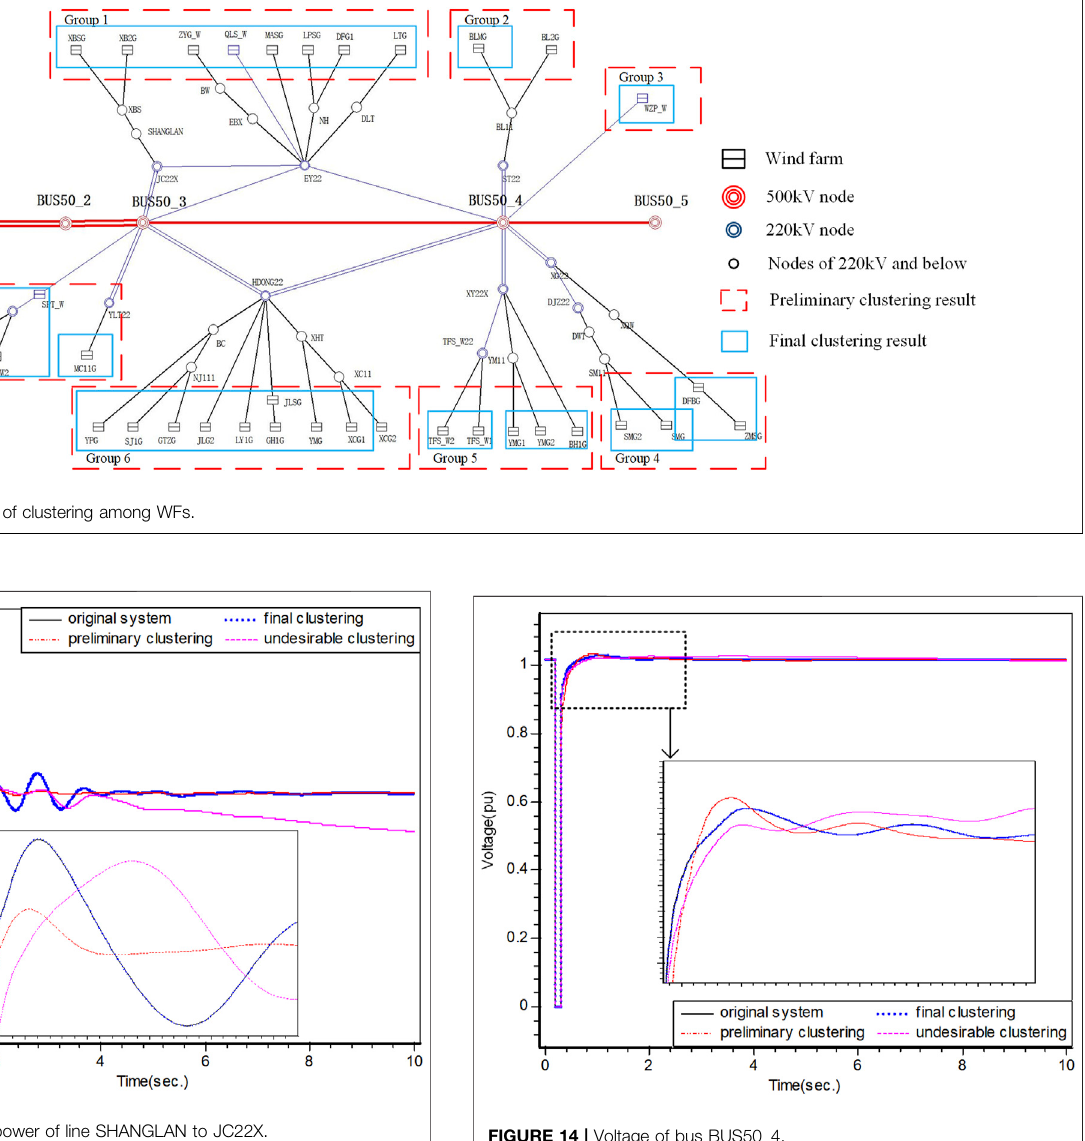
FIGURE 13 | Active power of line SHANGLAN to JC22X. FIGURE 14 | Voltage of bus